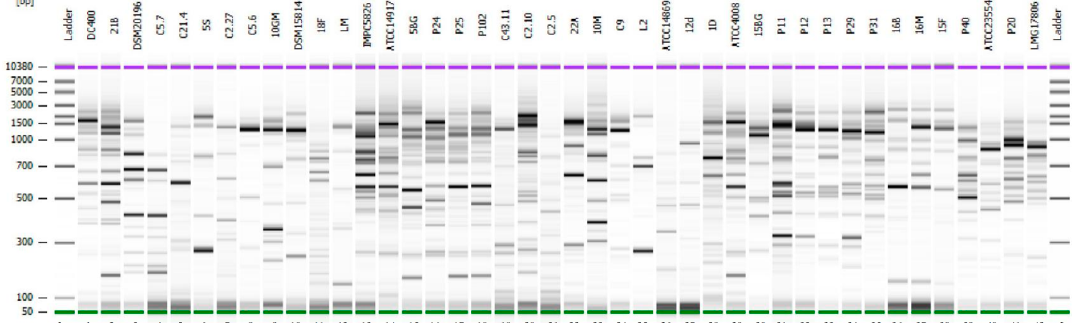
Figure 1. REP-PCR fingerprints of the 12 LAB strains in this study compared with other strains of